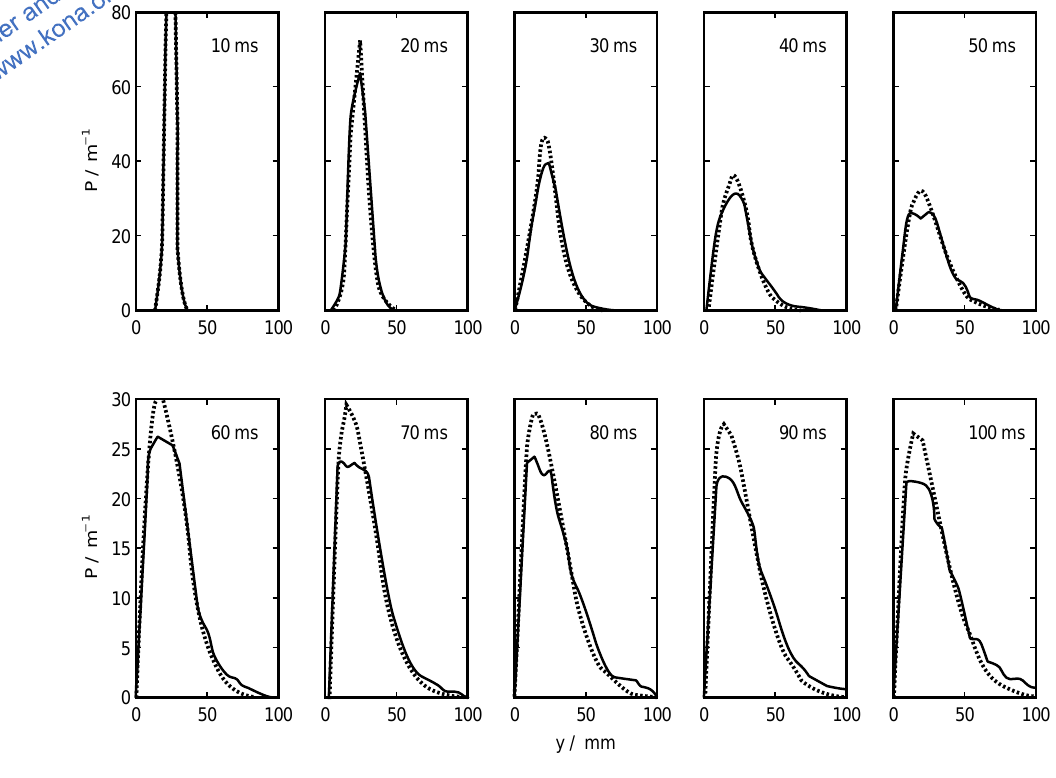
Evolution of the displacement probability density as a function of time for the bi-disperse case, up to 100 ms, showing the behaviour of each phase as a function of y. Solid line is the 4 mm displacement probability density, dashed is that for the 5 mm